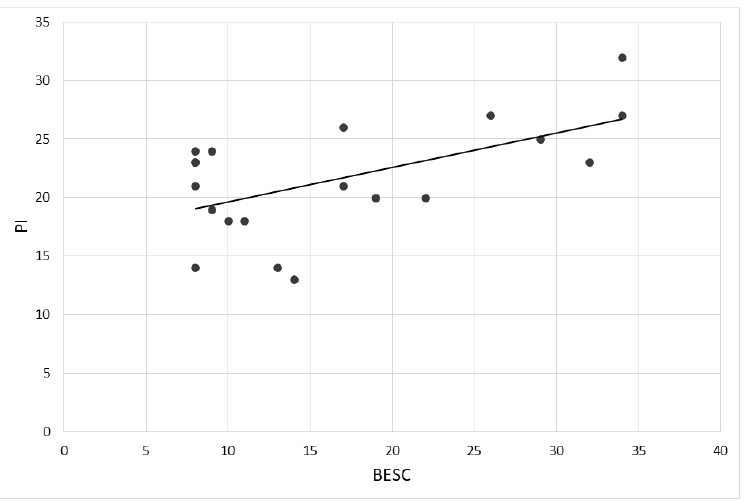
Figure 4. Correlation between Purchase Intention and Brand Engagement in self-concept. The graph represents the positive correlation between the Purchase Intention scale (PI) and the Brand Engage- ment in Self-Concept (BESC) scores found across all participants ( r = 0.576, p = 0.008).